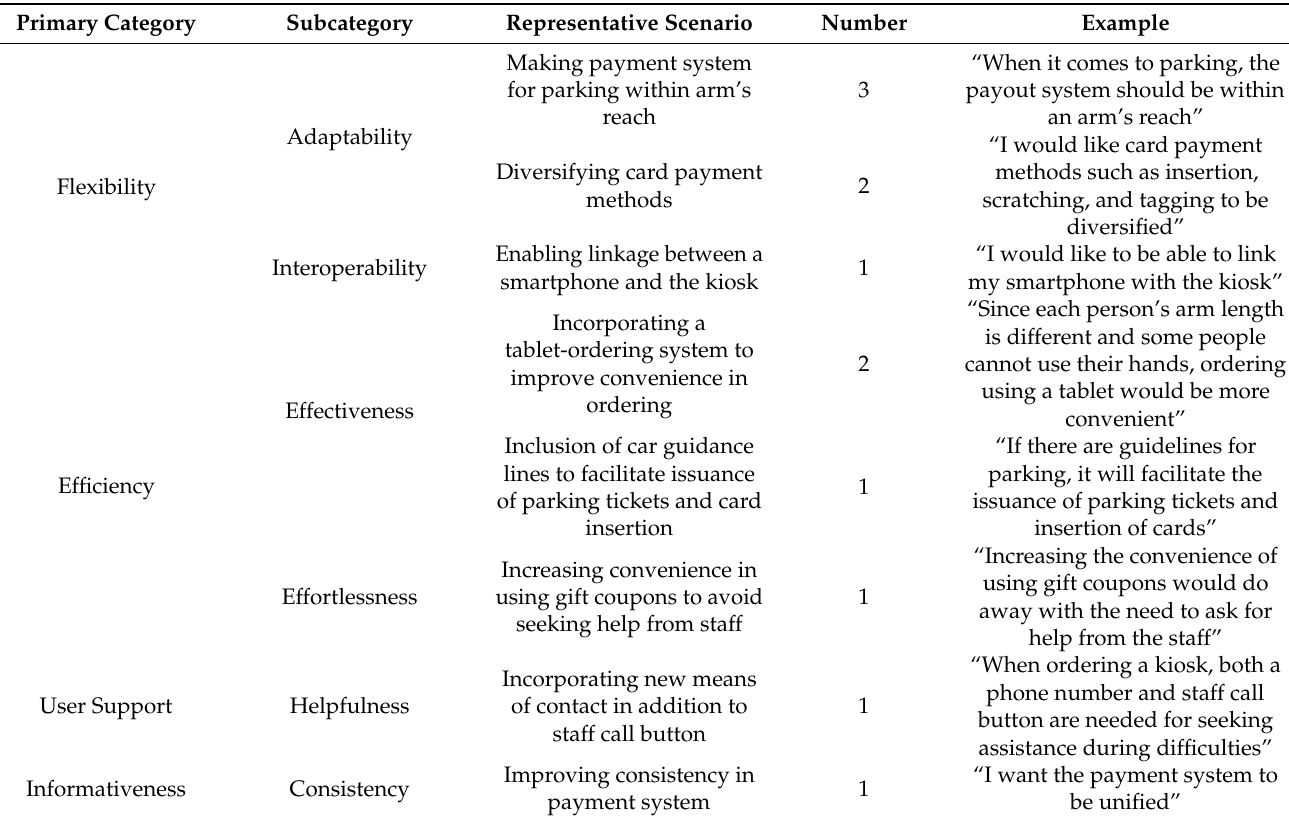
Table 8. Accessibility items for participants with physical